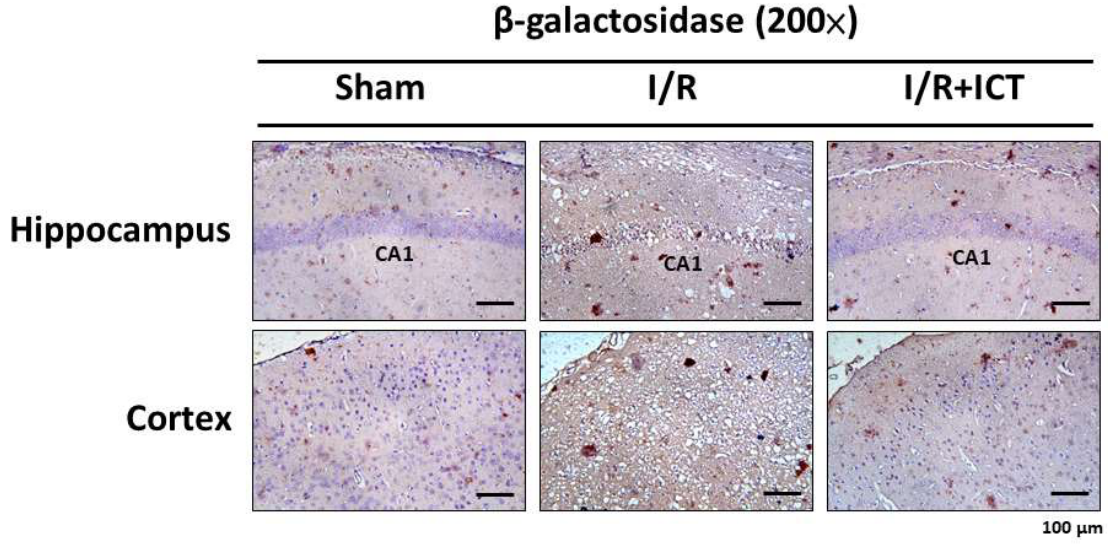
Figure 5. Effects of ICT treatment on the expression of senescence markers induced by MCAO in the cerebral hippocampus and cortex of mice. Immunohistochemical images of the expression of senescence-associated β-galactosidase (SA-β-gal) in the hippocampus and cortex of mouse brain sections. Images scale bar = 100 μm.